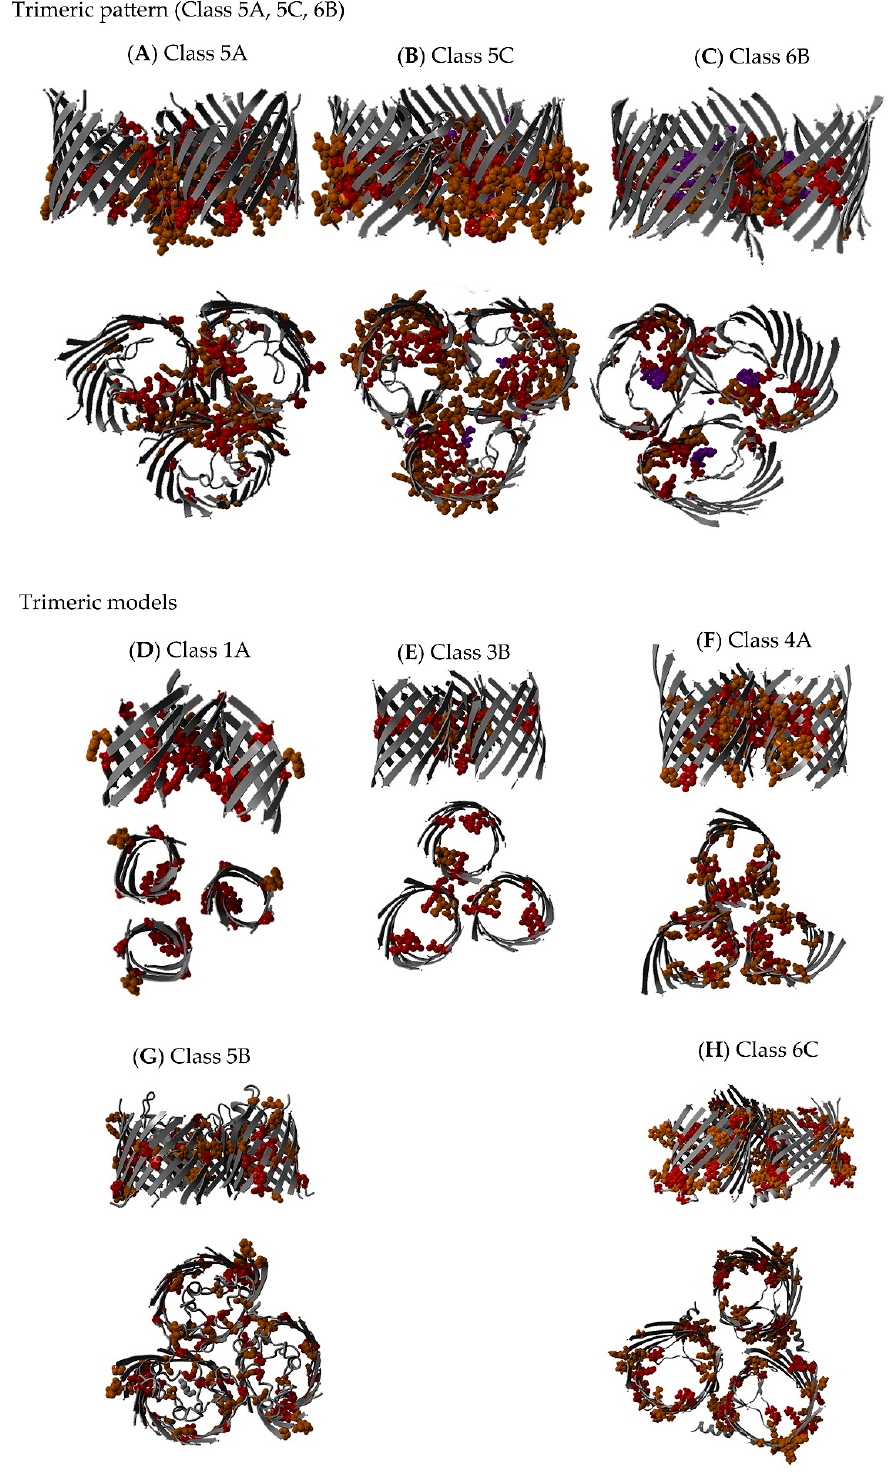
Figure 8. Non-specific porin and specific diffusion channel conservation. This figure illustrates differences in barrel size, pore size and loop variability. All structures are visualized in the trimeric form. Only the structures of Classes 5A ( A ); 5C ( B ); and 6B ( C ) proteins have been solved in an oligomeric conformation (all of them being homotrimeric). Class 1A ( D ); Class 3B ( E ); Class 4A ( F ); Class 5B ( G ) and Class 6C ( H ) are monomeric structures modeled in a trimeric conformation by hand. Same remark as the previous figures.